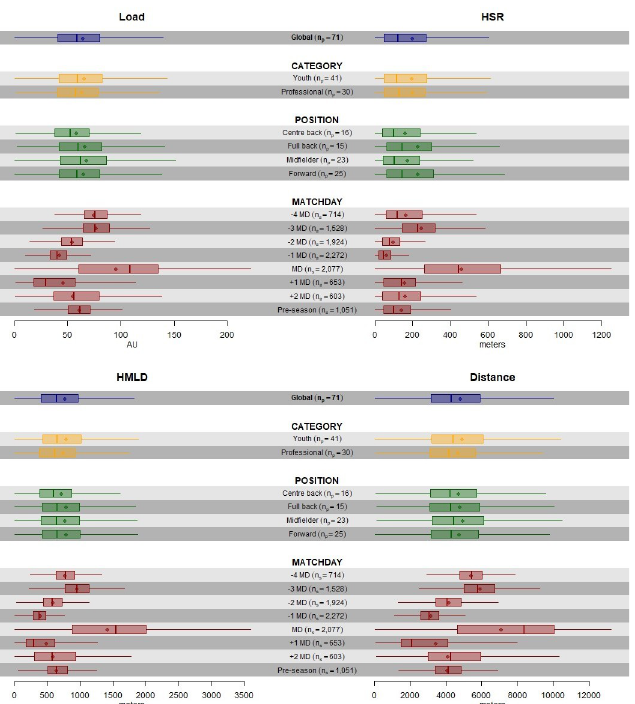
Fig 1. Boxplots without outliers of GPS load metrics by category, position, and training/match day. HMLD is high metabolic load distance; HSR is high speed running; n p is number of players; and n s is number of sessions. Note: Distance refers to Total Distance; Load refers to Player